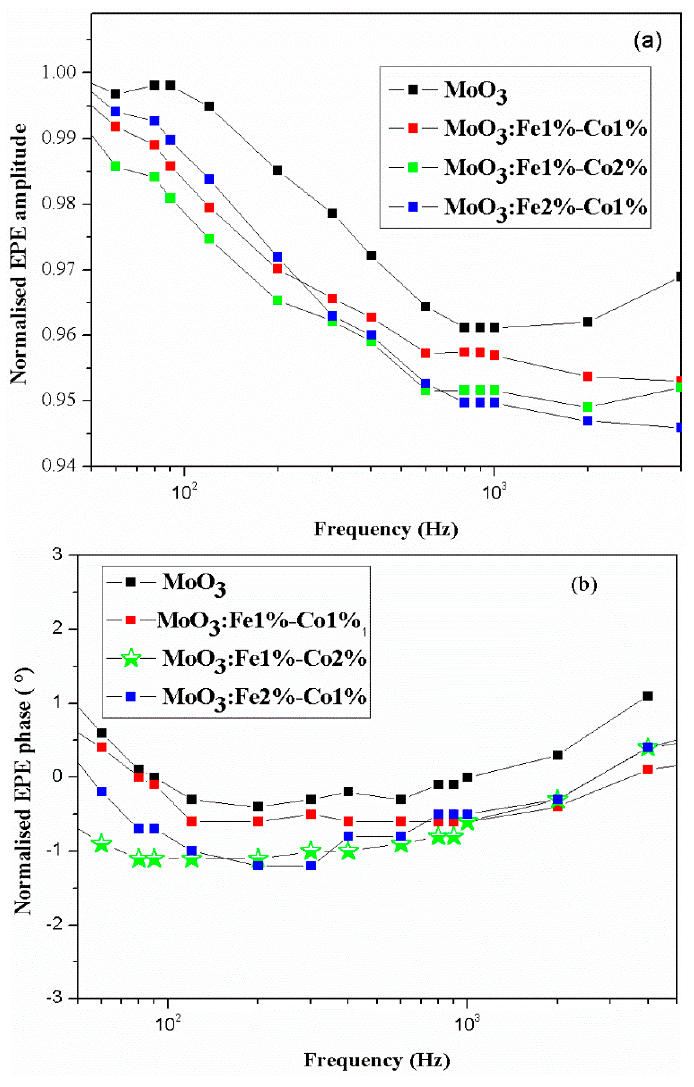
Figure 8. Experimental normalized amplitude ( a ) and phase ( b ) of the electropyroelectric signal for MoO 3 for different Fe and Co doping amount. EPE: ElectroPyroElectric. Table 6. Thermal parameters of Fe-Co doped MoO 3